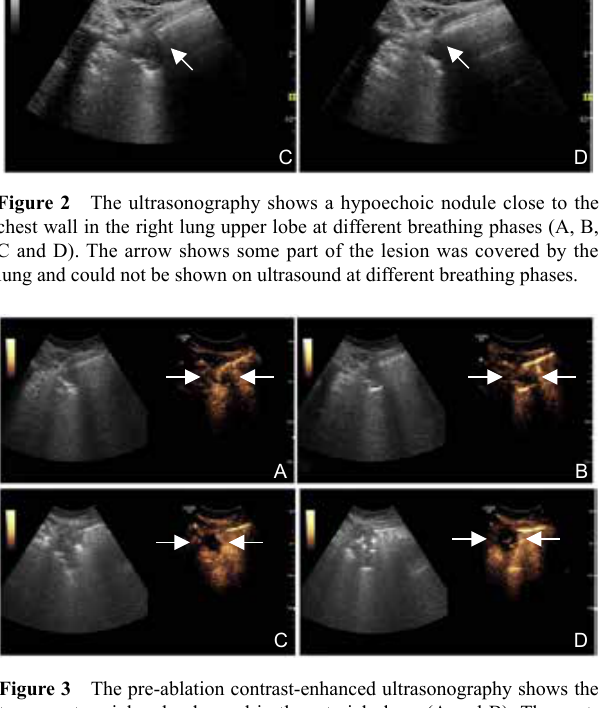
Figure 3 The pre-ablation contrast-enhanced ultrasonography shows the tumor got peripheral enhanced in the arterial phase (A and B). The post- ablation contrast-enhanced ultrasonography shows no enhancement of the lung metastasis (C and